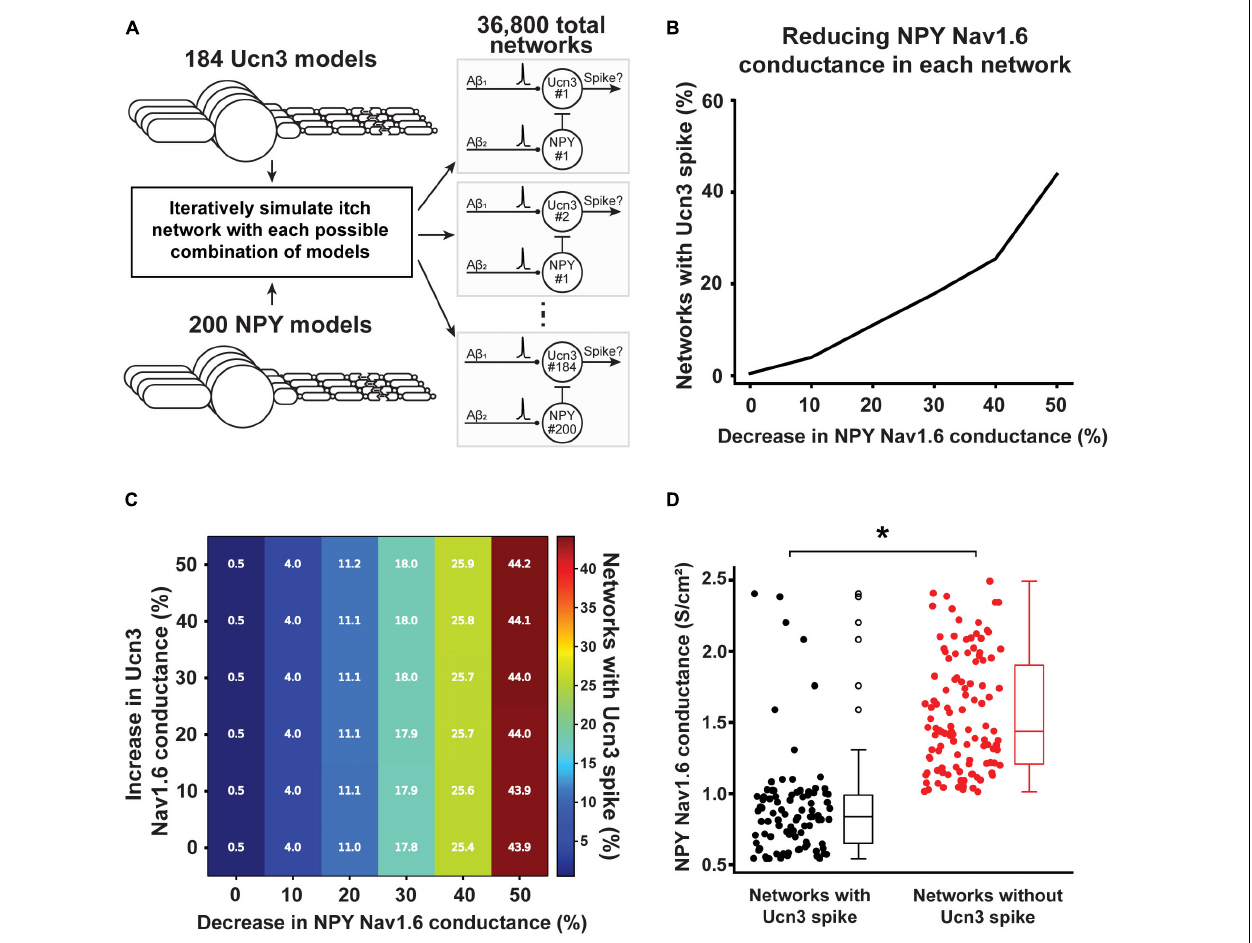
FIGURE 8 | Effect of calcipotriol-induced changes in ion channel expression on gating mechanical itch. (A) Simulating every permutation of the mechanical itch network with our 184 Ucn3 + model neurons and 200 NPY + model neurons. In total, we simulated 36,800 distinct networks. (B) Effect of decreasing Nav1.6 conductance in the NPY + model neuron on the percentage of networks producing a spike in its Ucn3 + model neuron. (C) Effect of simultaneously decreasing Nav1.6 conductance in the NPY + model neuron and increasing Nav1.6 conductance in the Ucn3 + model neuron on the percentage of networks producing a spike in its Ucn3 + model neuron. (D) Comparing the baseline Nav1.6 conductance in NPY + model neurons present in networks that produced a spike in the Ucn3 + model neuron (black) and networks that did not produce a spike in the Ucn3 + model neuron (red). * p < 0.001. Mann-Whitney U rank